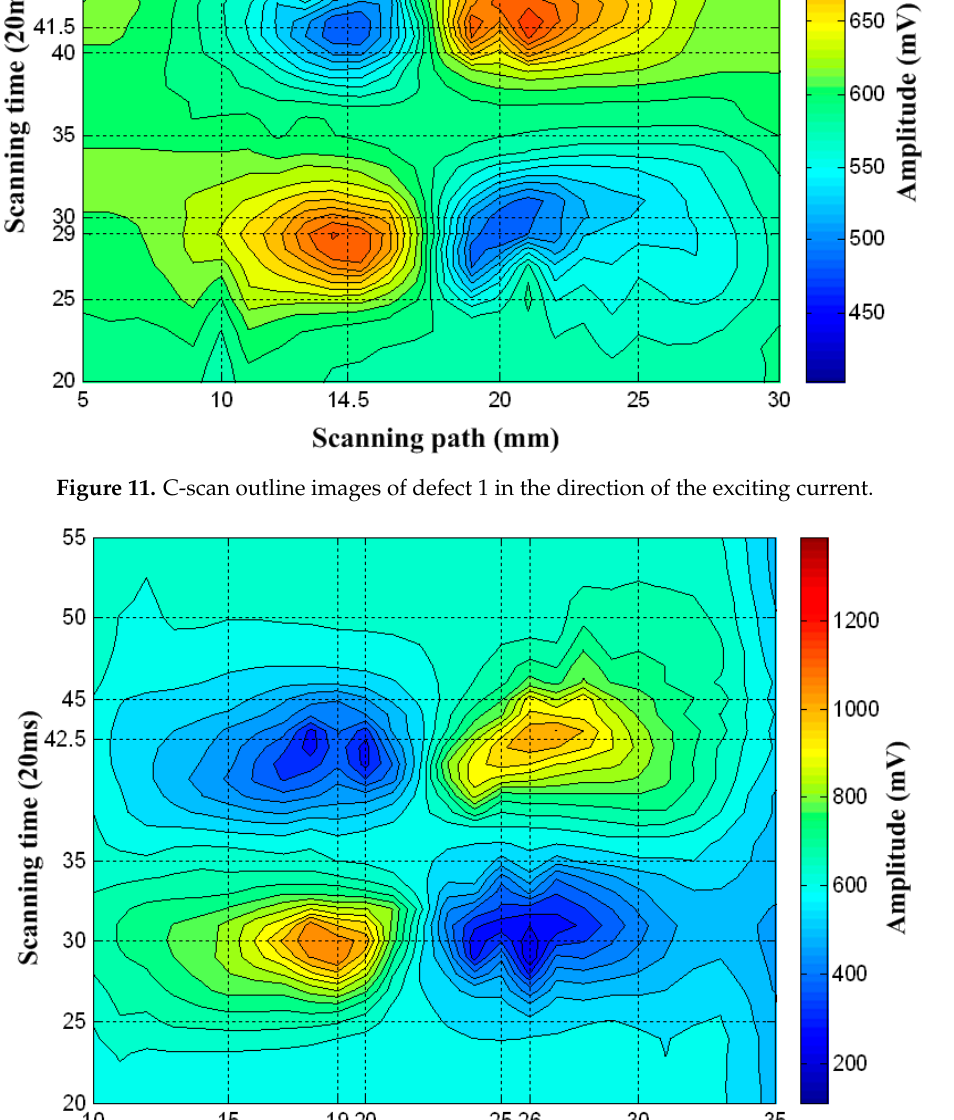
Figure 12. C-scan outline images of defect 2 in the direction of the exciting current.